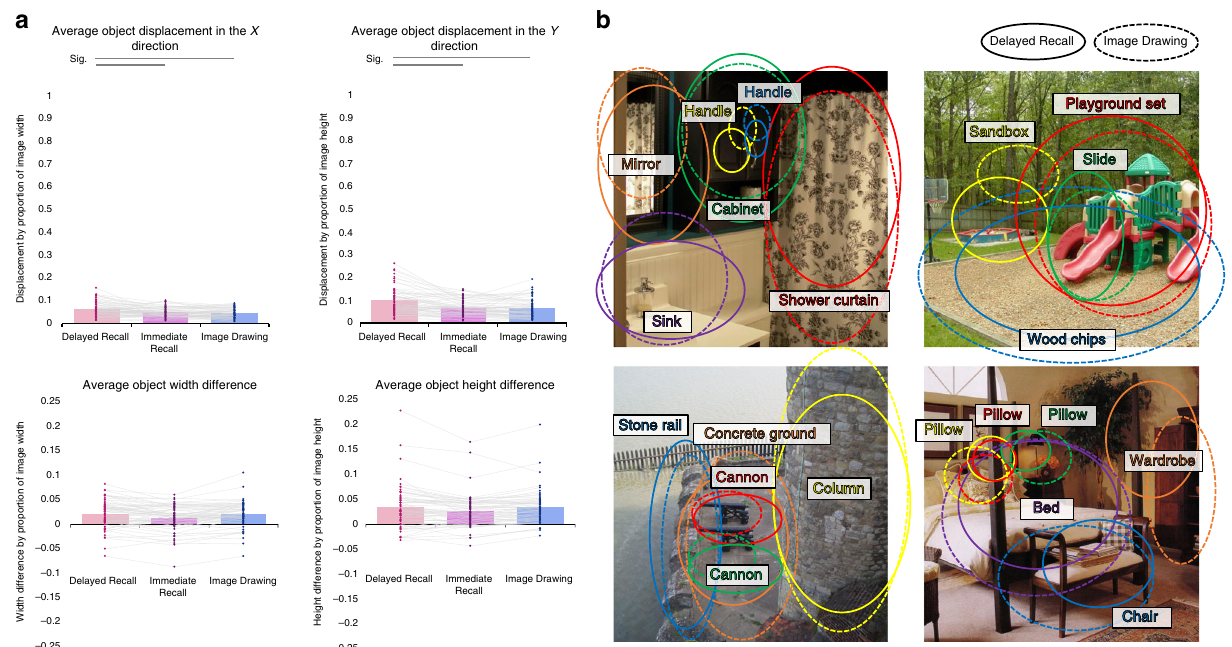
Fig. 4 Comparison of object location and size across conditions. a Top — the mean X and Y distance between object centroids of the different drawing conditions (Delayed Recall, Immediate Recall, Image Drawing) and object centroids in the original image. Object centroids were determined from ellipses placed around each drawn object by AMT workers. The y -axes represent the distance as the proportion of the x -direction (or y -direction) pixel distance between centroids and the image pixel width (or height). Bottom — the mean ellipsis width and height differences between objects in each drawing condition and the objects in the original images. Y axis values represent width and height differences as a proportion of image width and height, respectively. Each dot represents each of the 60 images used in the experiments, and lines connect the same image across conditions. Signi fi cance in Wilcoxon rank-sum tests between conditions is indicated with horizontal lines at the top (Bonferroni-corrected p < 0.0167). b Example maps of the average ellipse encompassing the most commonly drawn objects in four of the images. Solid ellipses indicate the average object location in the Delayed Recall drawings, whereas dashed ellipses indicate the average object location in the Image Drawings. Participants in both conditions drew objects in the correct locations and at the right sizes; e.g., in the bathroom, putting the mirror in the upper left, the cabinet in the upper middle, the shower on the right, and the sink on the bottom left. This shows that participants drawing from memory had spatially accurate memory representations, drawing objects in the correct places and correct sizes from objects they had seen in images 11-min